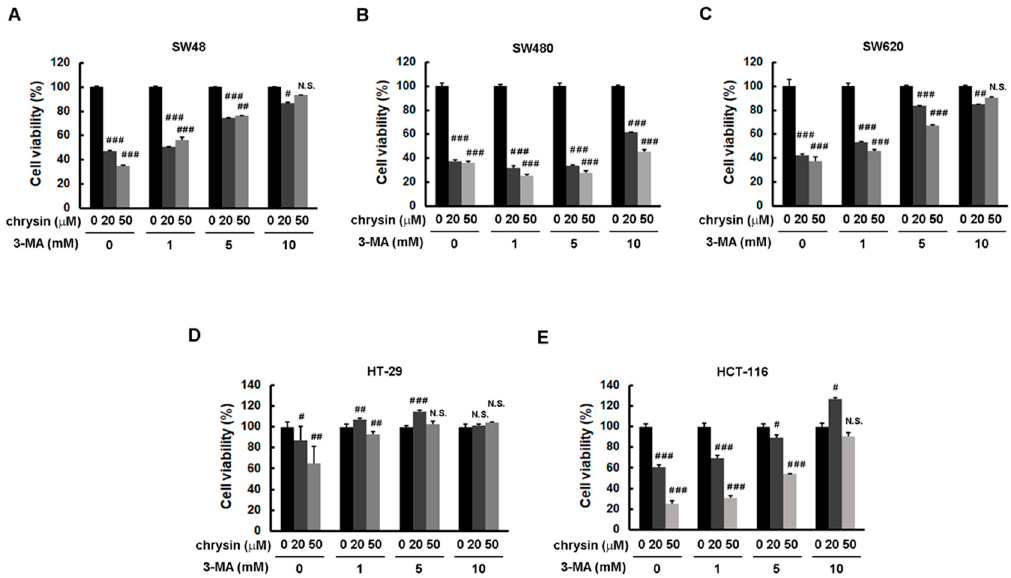
Figure 3. Blockage of autophagy induction reversed chrysin-attenuated colorectal cancer (CRC) cell viability. ( A – E ) Each CRC cell line was pretreated with the indicated concentration of 3-methyladenine (3-MA) followed by the indicated concentration of chrysin for three days. Cell viability was determined via a 3-(4,5-dimethylthiazol-2-yl)-2,5-diphenyltetrazolium bromide (MTT) assay, and was statistically quantified. # p < 0.05; ## p < 0.01; ### p < 0.001 when compared with indicated control groups. A p -value < 0.05 was considered as statistically significant. N.S.—not significant.